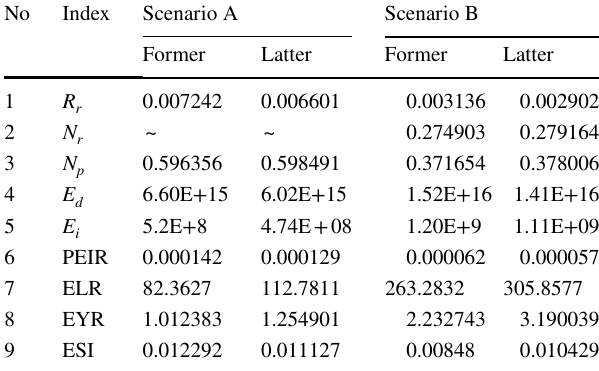
Table 8 The indicators changes between former and latter in Scenario A and Scenario